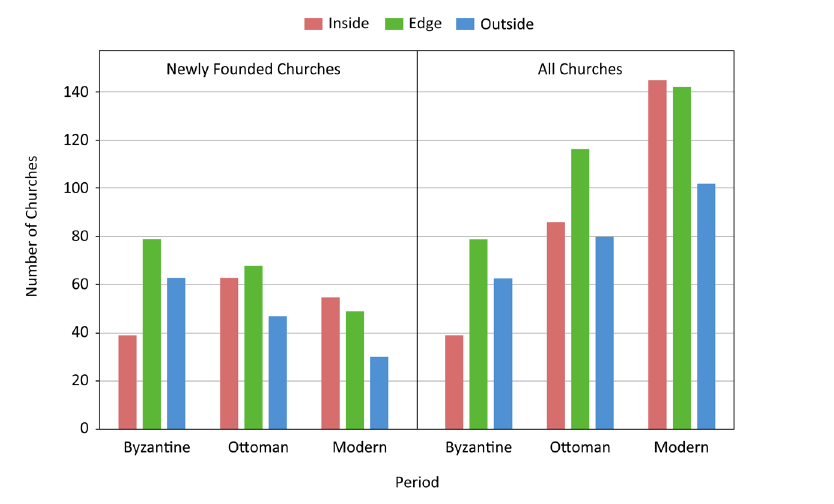
Figure 4. Visualization of the data in Table 2: number of churches in each topological category, by